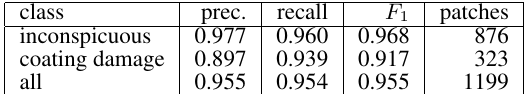
Table 1. The accuracy of a convolutional neural network (CCN) applied to coating damage classification in image patches from wind mill inspections.